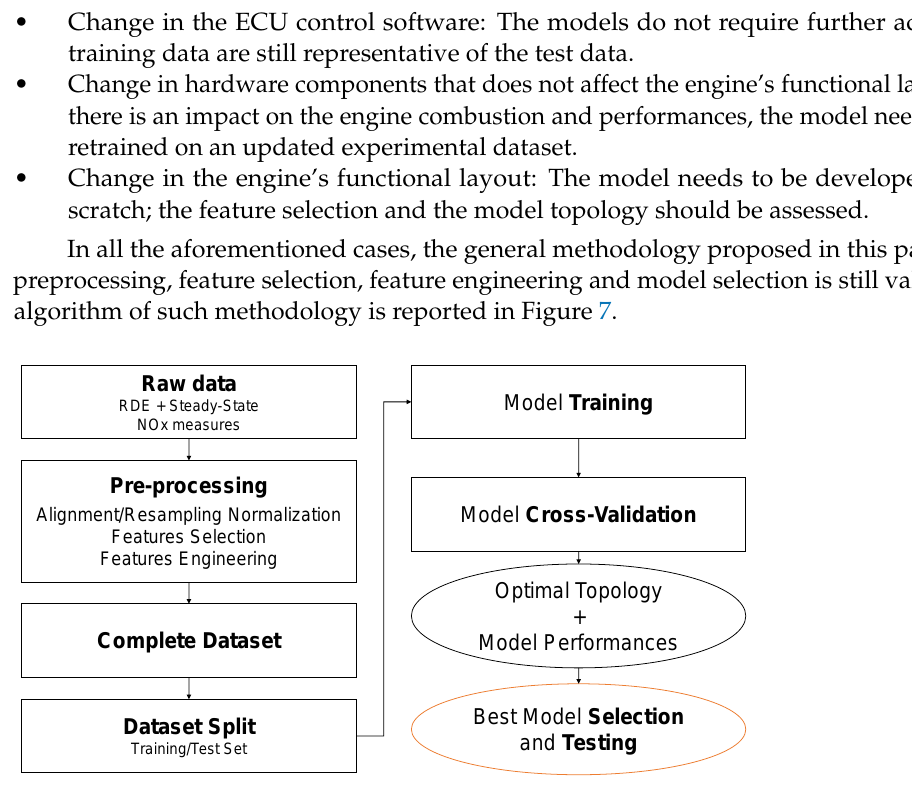
Figure 7. Flow chart of the main methodology